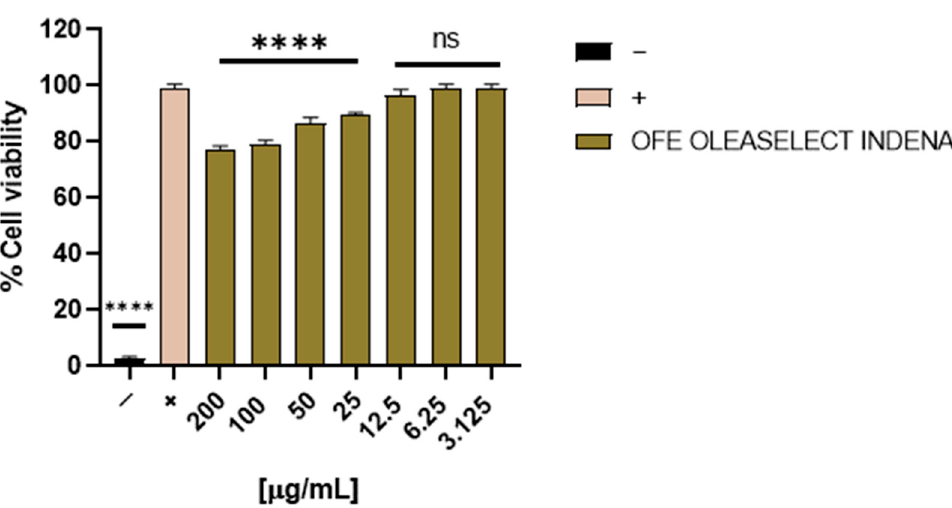
Figure 5. Cytotoxic activity of OFE. Cell viability was evaluated by MTT assay after Vero cell treatment with OFE for 24 h at different concentrations (from 200 to 3.125 µ g/mL). Non-treated cells were used as the positive control (+), whereas DMSO was used as the negative control ( − ). Statistical analyses were determined by one-way ANOVA with Dunnett’s test for multiple comparisons. Significances are referred to as the untreated cells (+). **** p < 0.0001; ns: non ‐ significant.